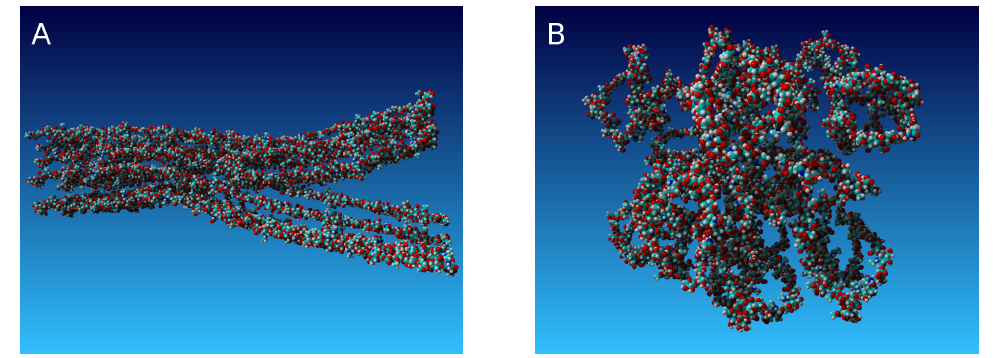
Figure 13. Initial structures of HA chains (water molecules and PL are not depicted): ( A ) a parallel (normal, inter-molecular) network is depicted; and ( B ) a coiled network (abnormal, intra-molecular) is